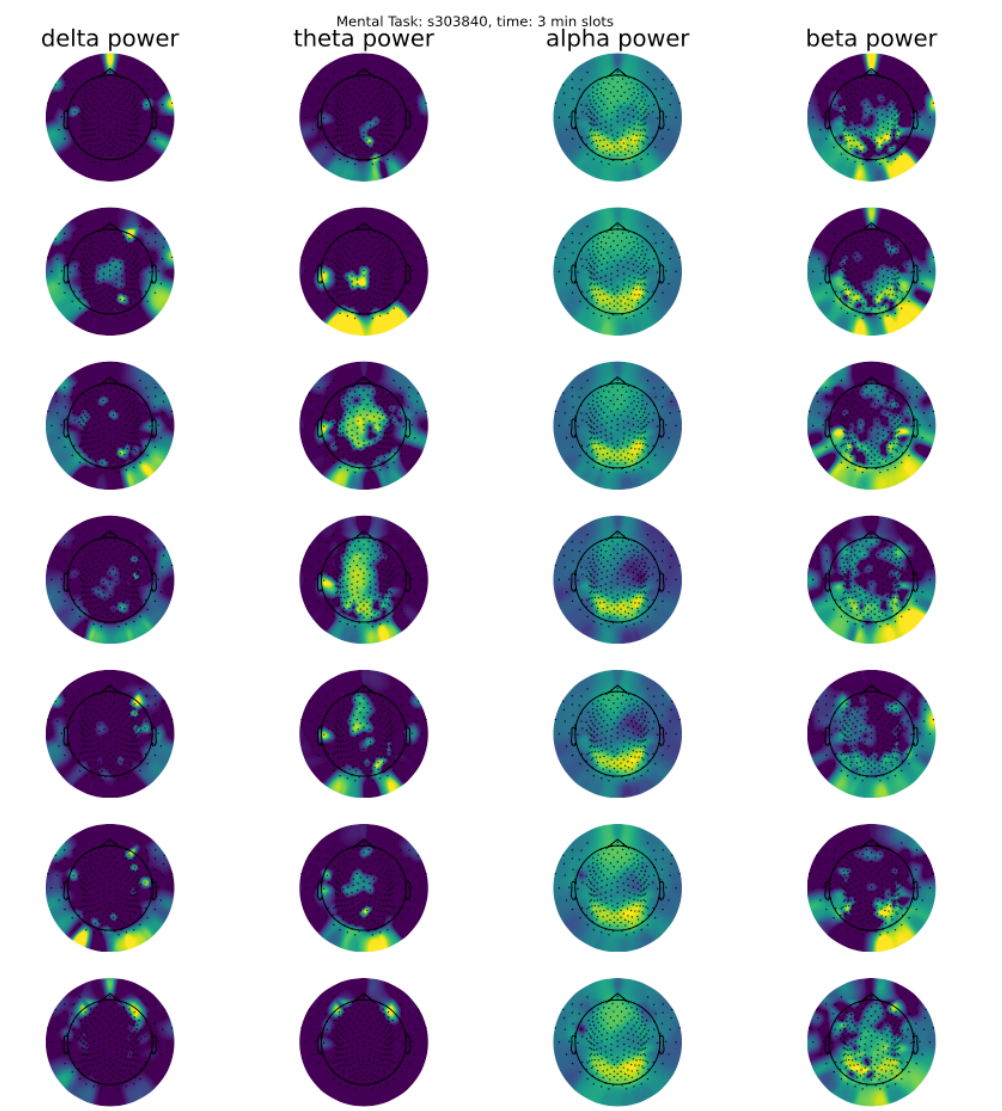
Figure 3. Power activity in the δ , θ , α , and β bands for participant s303840 exposed to mental task. Each row, one-by-one, represents a 3-min slot, for 21-min in total. For details, see the